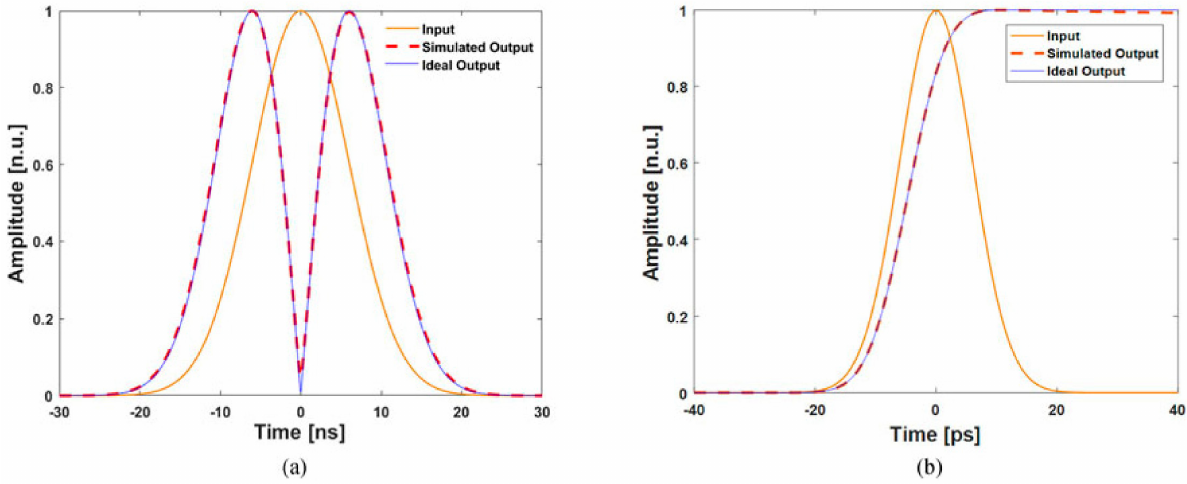
Figure 10. Simulation results for both the differentiation and the integration. ( a ) Input and output of the differentiator. ( b ) Input and output of the integrator. Adapted with permission from ref. [87]. © [2022]